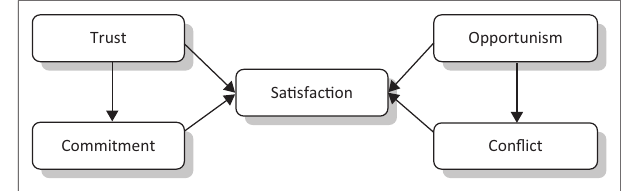
FIGURE 1: Conceptual